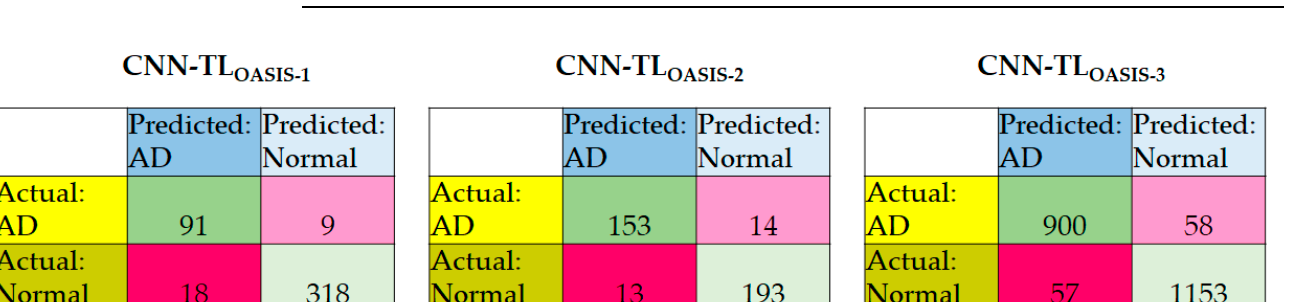
Figure 5. Confusion matrices of the CNN-TL OASIS-1 , CNN-TL OASIS-2 , and CNN-TL OASIS-3 .